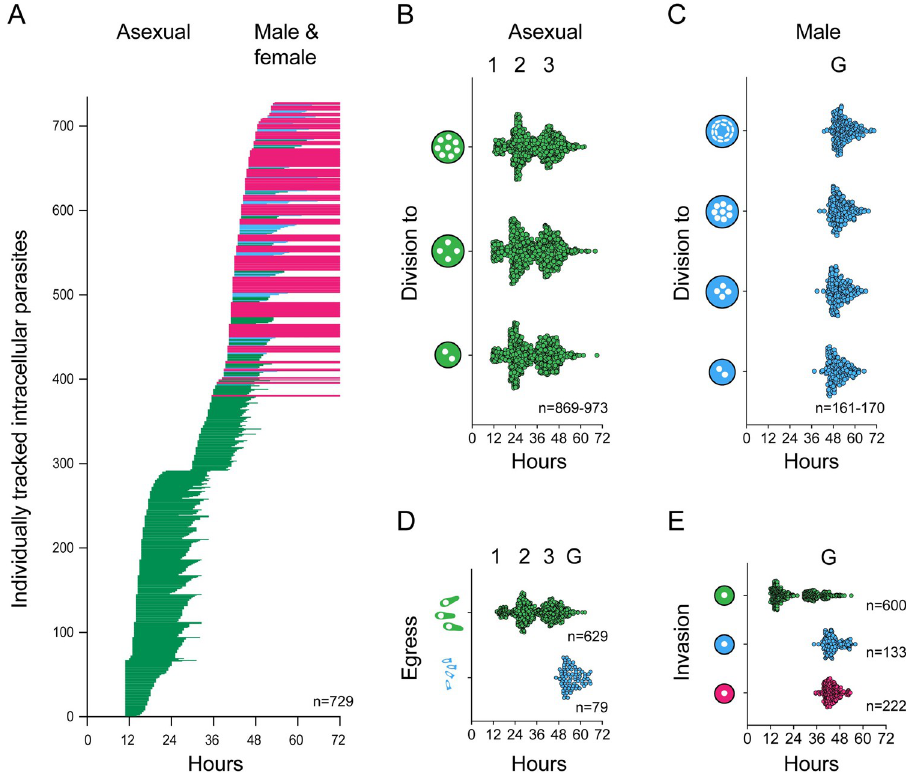
Fig 3. Extended time-lapse imaging reveals 3 cycles of asexual schizogony followed by differentiation into gametes. (A) Individually tracked parasites over time. Each horizontal line represents an individual parasite from invasion to egress (green = asexual, blue = male, and pink = female). Lines for females cutoff at 72 hours, as we do not observe egress of these parasites. Parasites with observed egress, but which invaded prior to the start of the experiment are included with lines beginning at 11 hours ( n = 729). (B) Individually plotted nuclear division events for asexual parasites over time. The time point at which we observe 2, 4, or 8 nuclei for the first time for parasites designated as asexual are plotted as individual points over time ( n = 869 to 973). (C) Individually plotted nuclear division events for male parasites over time. The time point at which we observe 2, 4, 8, or 16 nuclei for the first time for parasites designated as male are plotted as individual points over time ( n = 161 to 170). (D) Individually plotted egress events for both asexual (green) and male (blue) parasites over time. The time at which we no longer observe a parasite is designated the time of egress. Each point represents a single asexual meront or male gamont. There are 3 distinct clusters of asexual egress events and a single cluster of male egress events (asexual n = 629, male n = 79). (E) Individually plotted invasion events for asexual (green), male (blue), and female (pink) parasites over time. The time at which a parasite is first observed is considered the time of invasion. There are 2 observed clusters of invasion events leading to asexual parasites and only 1 cluster leading to male or female cells, respectively (asexual n = 600, male n = 133, and female n = 222). Underlying data are provided in the Supporting information as S2